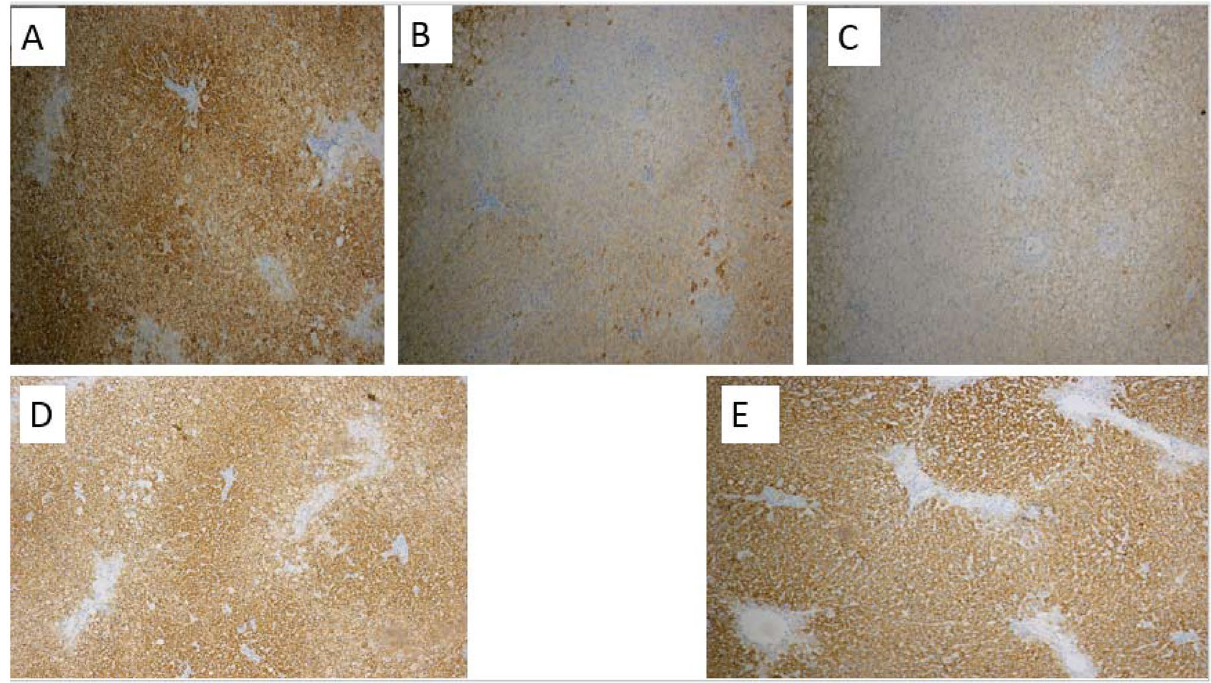
Figure 5. Immunohistochemical staining for hepatocyte specific antigen (HepPar1). ( A ) Controls showed a strong signal with Hep Par 1 (hepatocyte marker) producing distinct granular, cytoplasmic staining of hepatocytes, whereas in both ( B ) NASH (9 weeks) and ( C ) NASH (12 weeks) groups were mostly negative with HepPar-1. By comparison, (96%) hepatocytes in ( D ) Early Kefir group were immunoreactive for HepPar-1 and ( E ) Late Kefir group tended to show weaker, patchy positivity (HepPar1 × 100) indicated to hepatocyte differentiation.